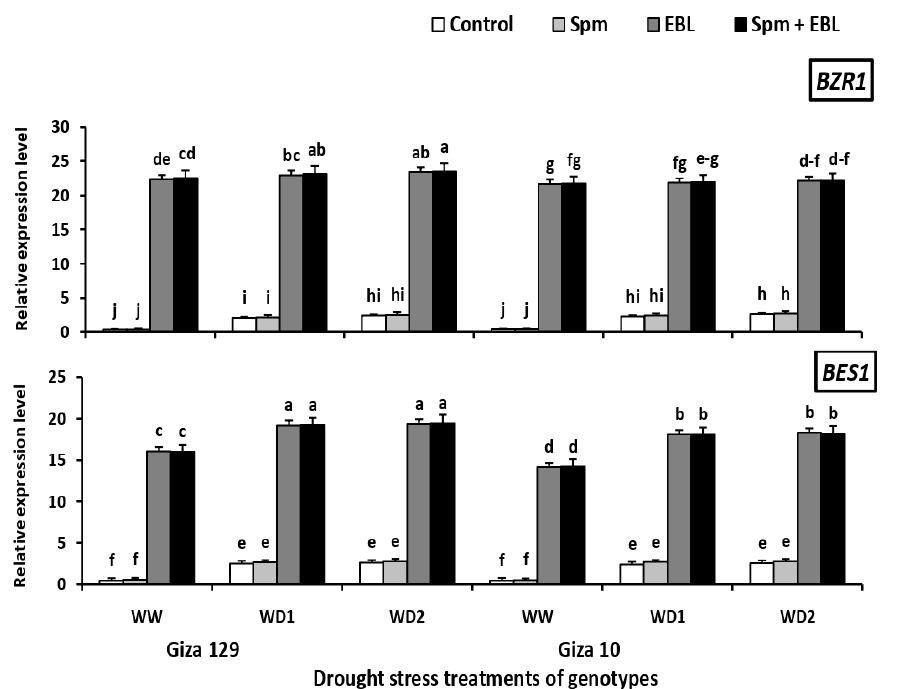
Figure 2. Relative levels of expression of Zea mays protein BZR1 homolog 1-like ( ZmBZR1 ) and Zea mays protein BES1 ( ZmBES1 ) genes compared with the ubiquitin carrier protein ( ZmUBCP ) gene were analyzed in leaves of maize plants after seven days of foliar application with distilled water (control), 25 mg L − 1 Spm, 0.1 mg L − 1 EBL, or 25 mg L − 1 Spm + 0.1 mg L − 1 EBL to both genotypes—Giza 129 and Giza 10—exposed to drought stress treatments (control (100% field capacity (FC); WW) and water deficit (75% FC and 50% FC; WD1 and WD2)). Values are the mean ±SE (n = 6). Different letters indicate significant differences at p < 0.05 level according to LSD test.